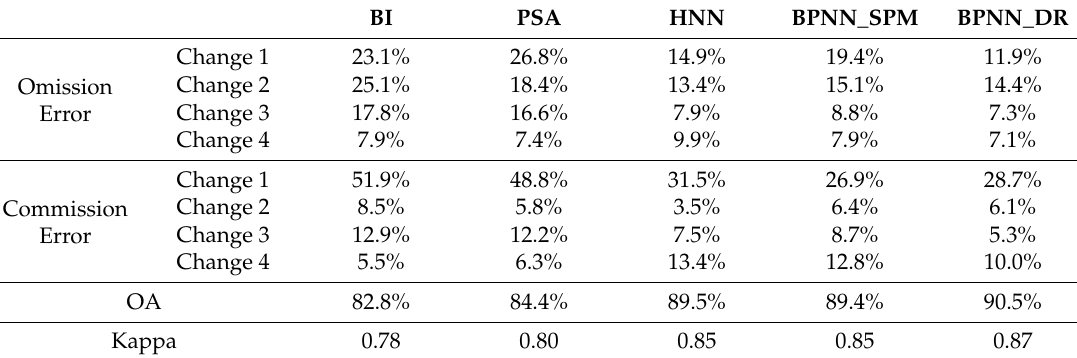
Table 2. The accuracy statistics of the five methods for synthetic images.